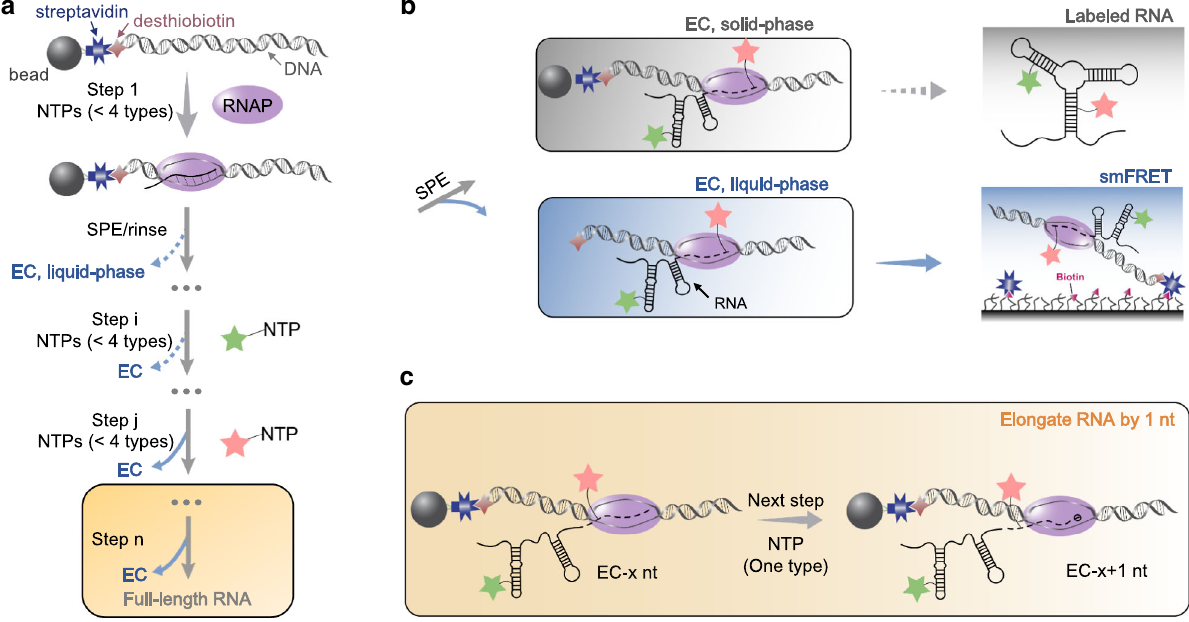
Fig. 1 | Schematic illustration of co-transcriptional study of ECs labeled with a FRET pair atspeci fi c positions.a The hybrid phase transcription is dividedinto n steps by a pause-restart mode (following gray arrows), with labels (green and pink stars) incorporated into speci fi c positions of RNA at steps i and j. The pause and restartateachsteparepreciselycontrolledbyadditionsoflimitedNTPstothesolid phaseECs.The5 ’ -desthiobiotin-labeledDNAtemplatesarecoupledtostreptavidin- coated agarose beads. The solid phase EC contains DNA templates (gray ribbon), RNAP (purple sphere), nascent transcript (black line) and streptavidin-bead (gray sphere). During transcription, partial ECs are dissociated from beads, generating